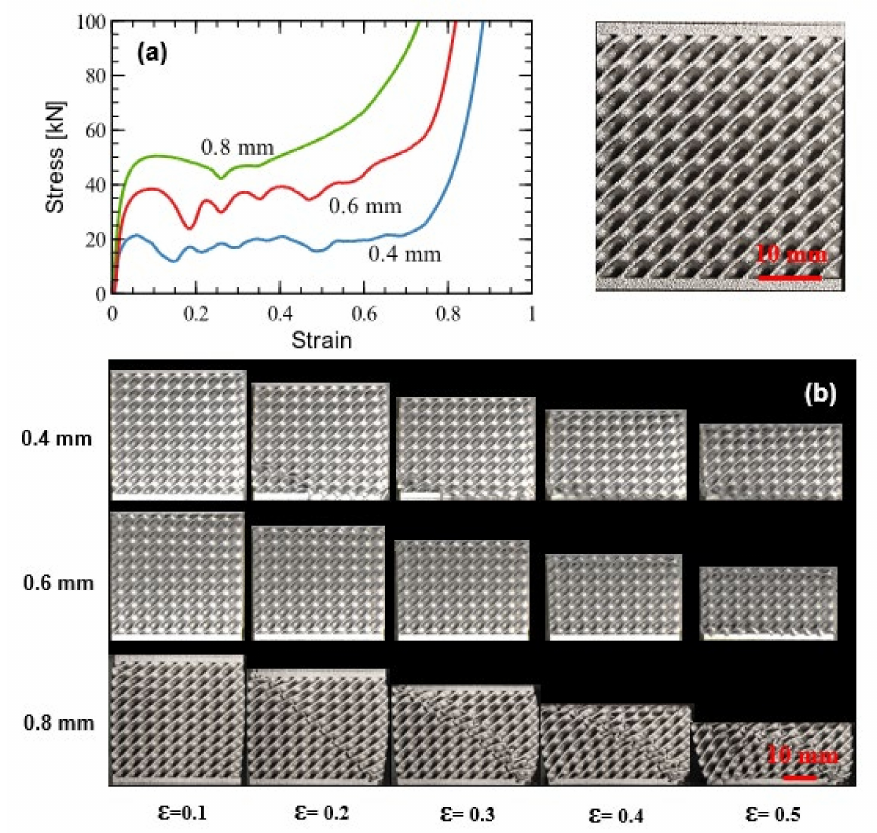
Figure 14. ( a ) Stress–strain curves for diamond TPMS structure under compression with 0.4, 0.6 and 0.8 mm wall thicknesses, and ( b ) diamond TPMS deformation sequence for each of the three wall thickness specimens at increasing strain.